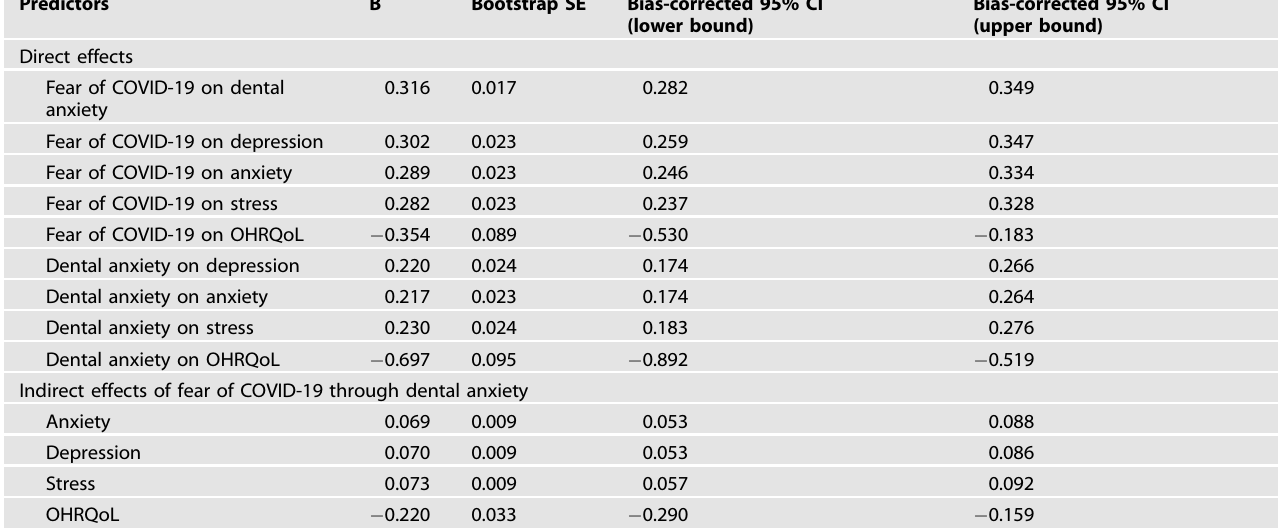
Table 3. Predictors for both oral-health-related Quality of Life (OHRQoL) and psychological